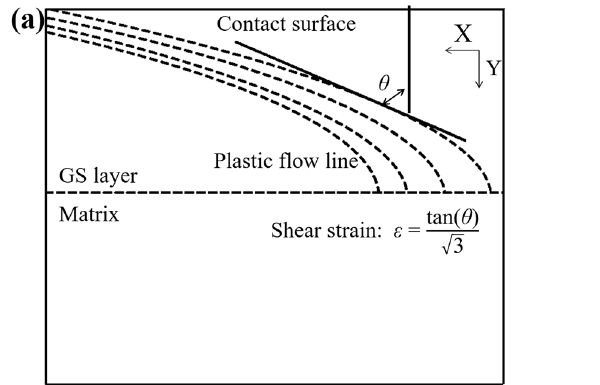
Figure 8. ( a ) Schematic of the shear strain and ( b ) curves of shear strain along with the depth.